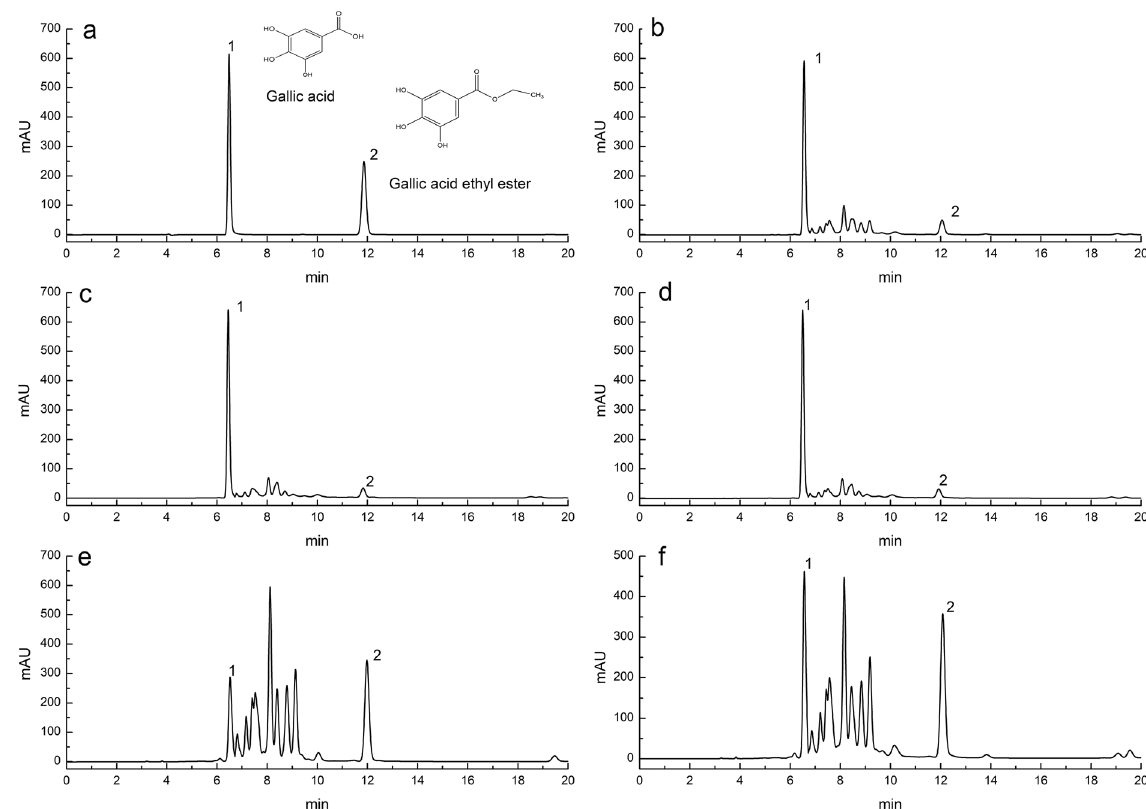
Fig. 3 Chromatograms of secondary residues of Turkish Gall under different treatment conditions ( a Standard solution; b Water treat; c Hydrochloric acid buffer treat; d Artificial gastric juice treat; e , Phosphate buffer treat; f Artificial intestinal solution treat; 1 represents gallic acid and 2 represents gallic acid ethyl